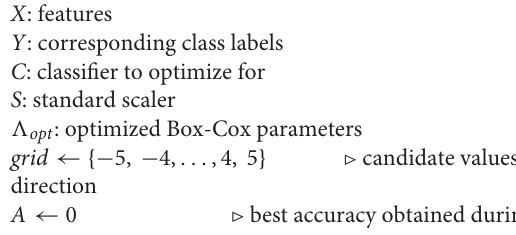
Algorithm 5 : 2D grid search( X , Y , C )